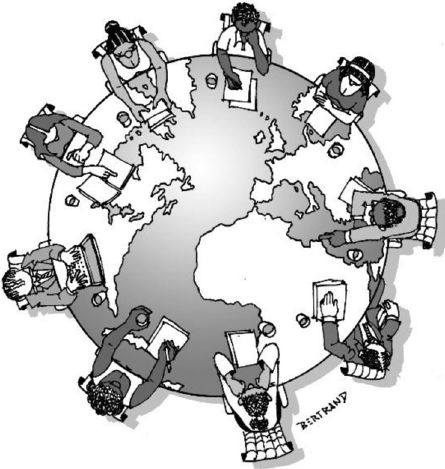
Figure 1. Soft side